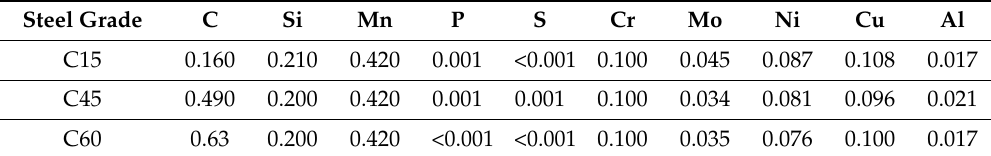
Table 1. Chemical composition of the steel samples in wt %.